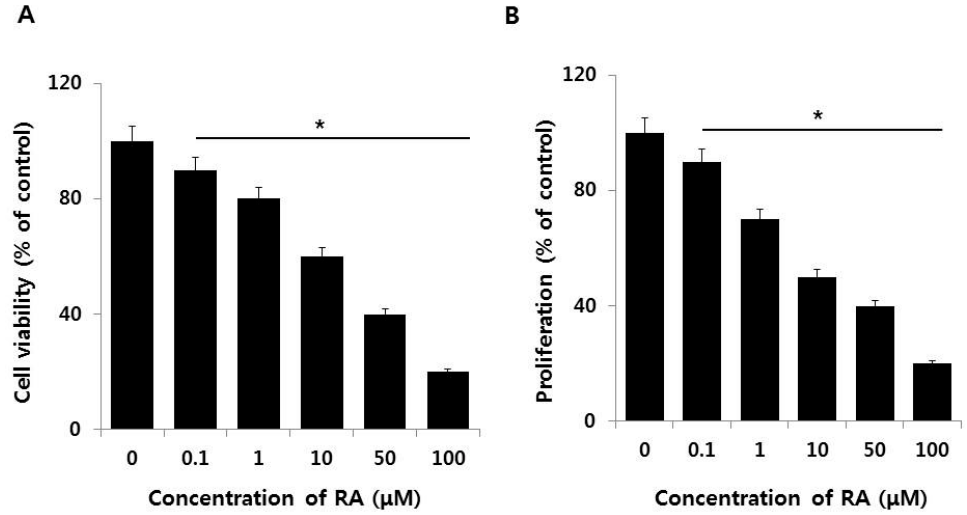
Figure 3. Effect of RA on cell viability and proliferation of F9 cells. The viability ( A ) and proliferation ( B ) of F9 cells were determined after a 24 h exposure to different concentrations of AuNPs (0.1–100 μ M). At least three independent experiments were performed for each sample. The treated groups